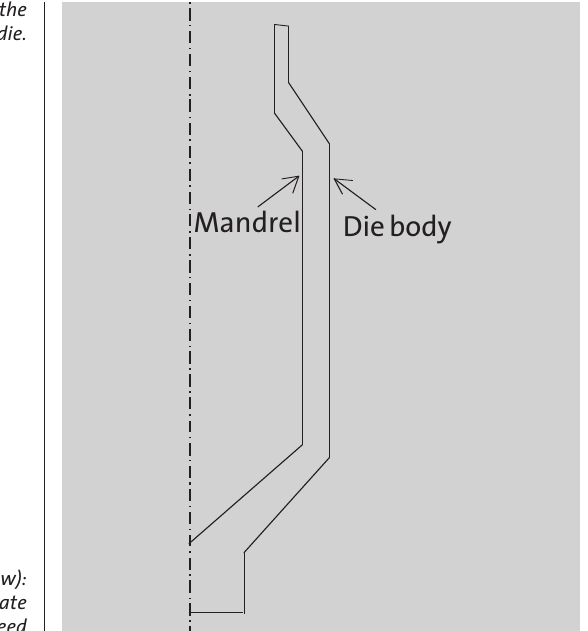
Figure 2: Sketch of the annular spider die.